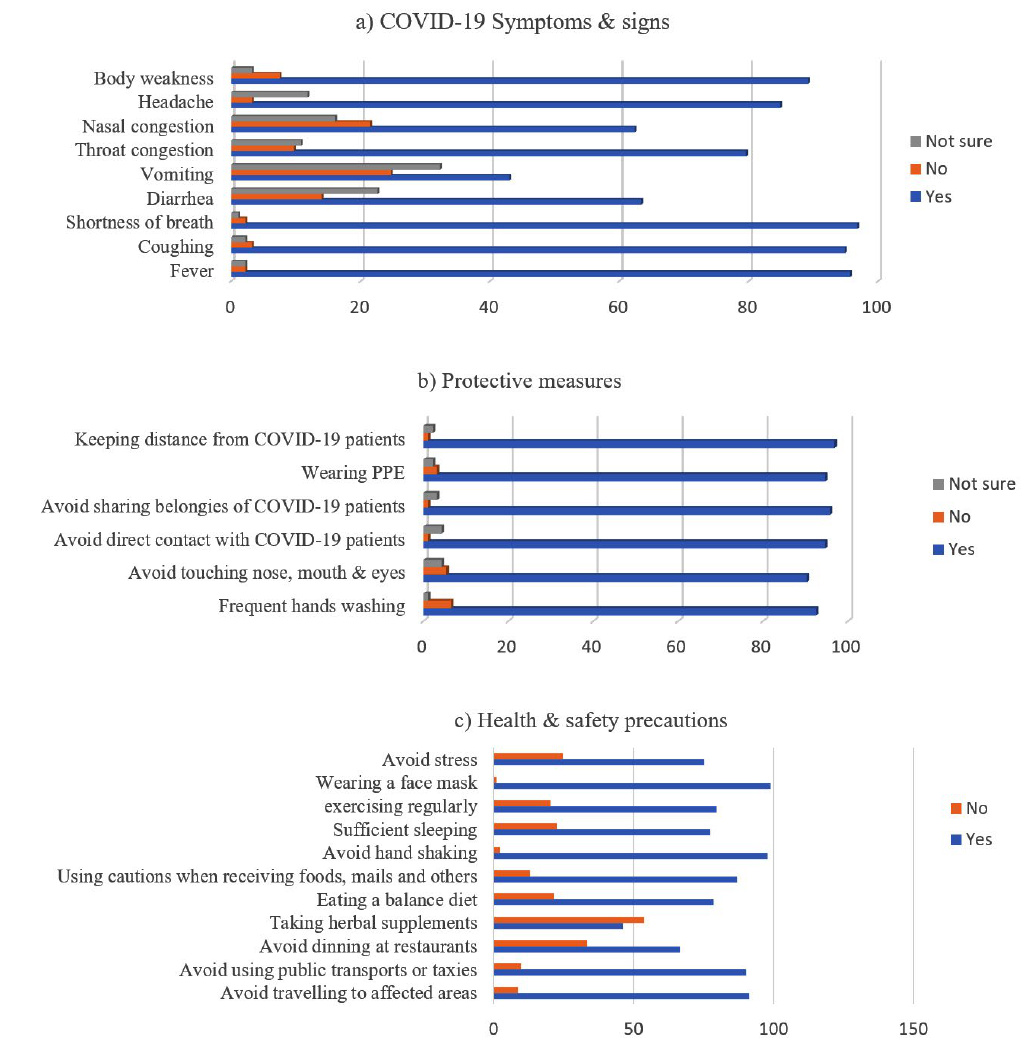
Fig. 1. Level of awareness of participants regarding COVID-19: a) symptoms and signs, b) protective measures, and c) health and safety precautions that people had to follow to reduces the risk of